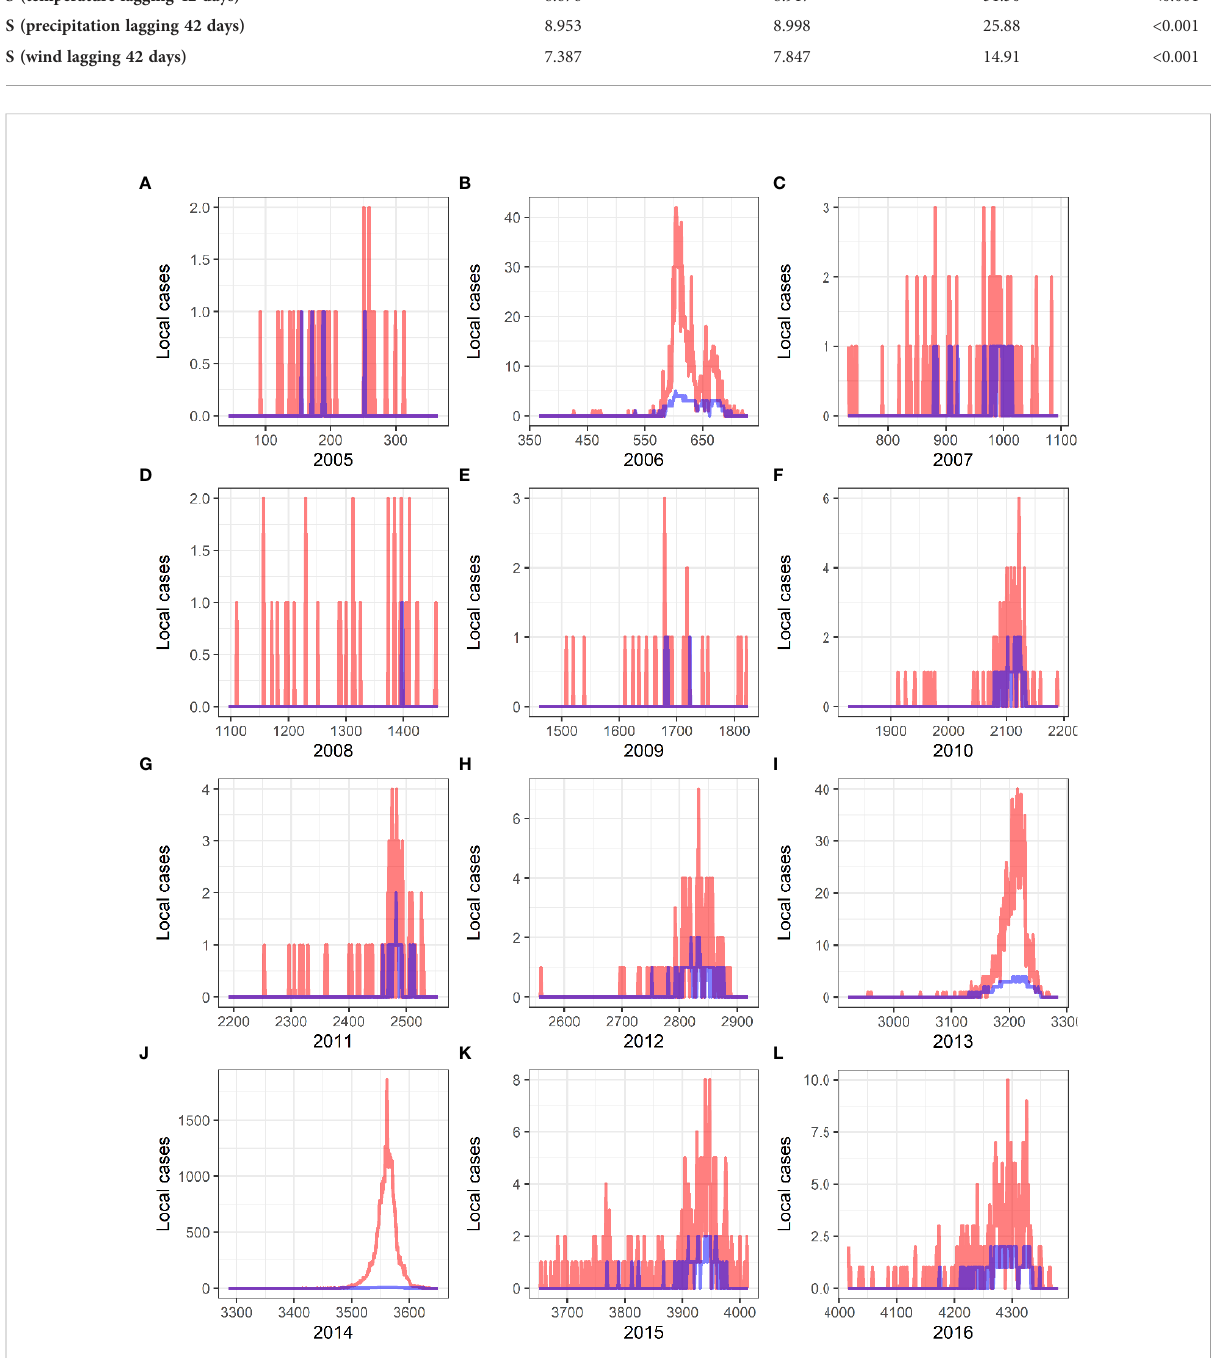
FIGURE 6 Veri fi cation of predictive results and actual incidence of local dengue fever from 2005 to 2016 in China. Red curves present the actual cases, and blue curves are the predicted curves created by Generalized Additive Models. (A) 2005. (B) 2006. (C) 2007. (D) 2008. (E) 2009. (F) 2010. (G) 2011. (H) 2012. (I) 2013. (J) 2014. (K) 2015. (L)